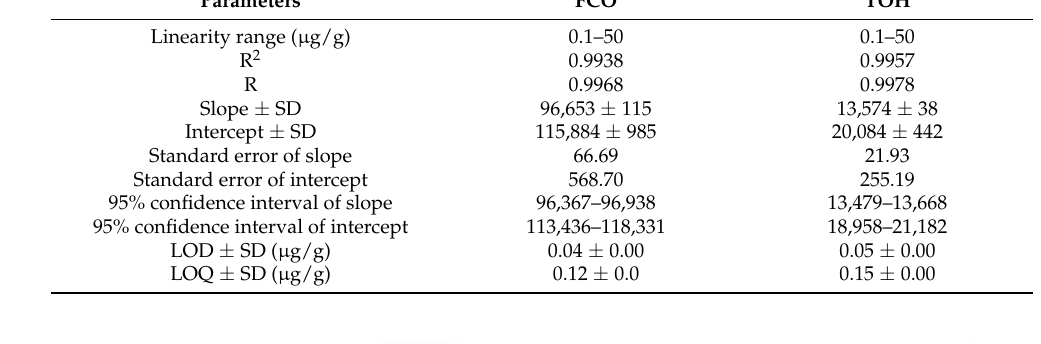
Table 1. Results for linear regression analysis for the simultaneous determination of fenchone (FCO) and trans -anethole (TOH) using gas chromatography–mass spectrometry (GC-MS) approach (mean ± SD; n = 3). Parameters FCO TOH